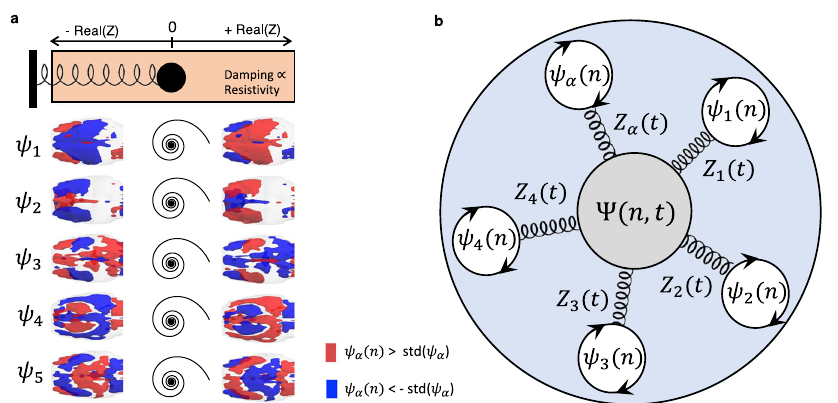
Fig. 9 | Mechanistic model for the spontaneous resonance of standing waves driving the activation of functional brain networks. a Like the response of spring, the temporal signature of brain modes can be approximated by a damped oscillator. Despite the lower temporal resolution inherent to multi-slice acquisi- tions hindering the detection of resonant behavior, the consistency of spatial patterns reinforces the hypothesis that the damped oscillatory response of